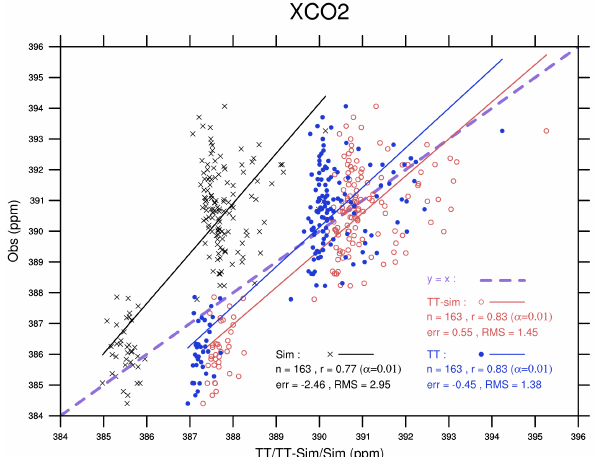
Figure 14. Comparisons between the observed X CO 2 and the open- loop GEOS-Chem-simulated (Sim), Tan-Tracker-assimilated (TT) and the TT-Sim (i.e., the GEOS-Chem model run without data as- similation forced by the TT-optimized CF series derived from the Tan-Tracker assimilation run with the TT-assimilated initial CO 2 fields at 1 January 2010) simulated X CO 2 on 15 March